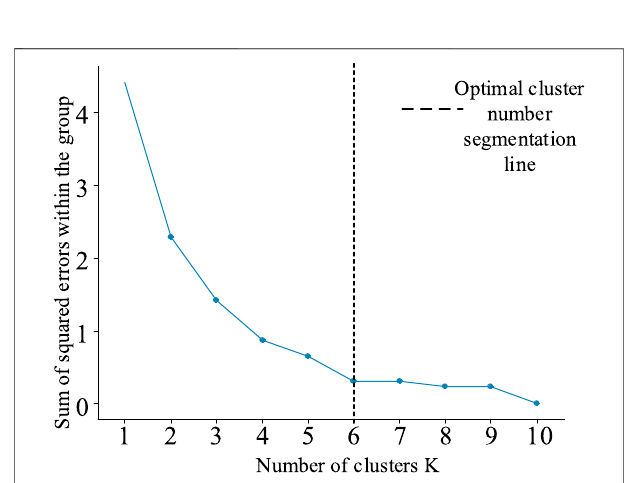
FIGURE 4 | Sum of squared errors of photovoltaic output fl uctuation.